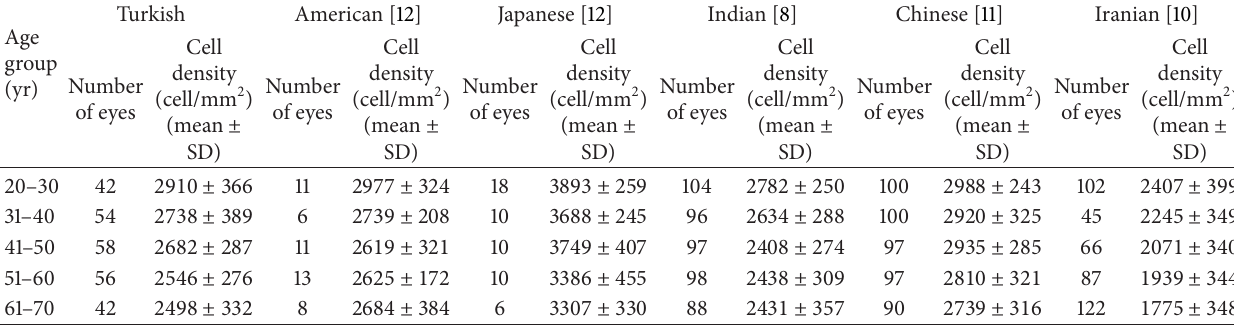
Table 5: Comparison of endothelial cell density in Turkish, American, Japanese, Indian, Chinese, and Iranian